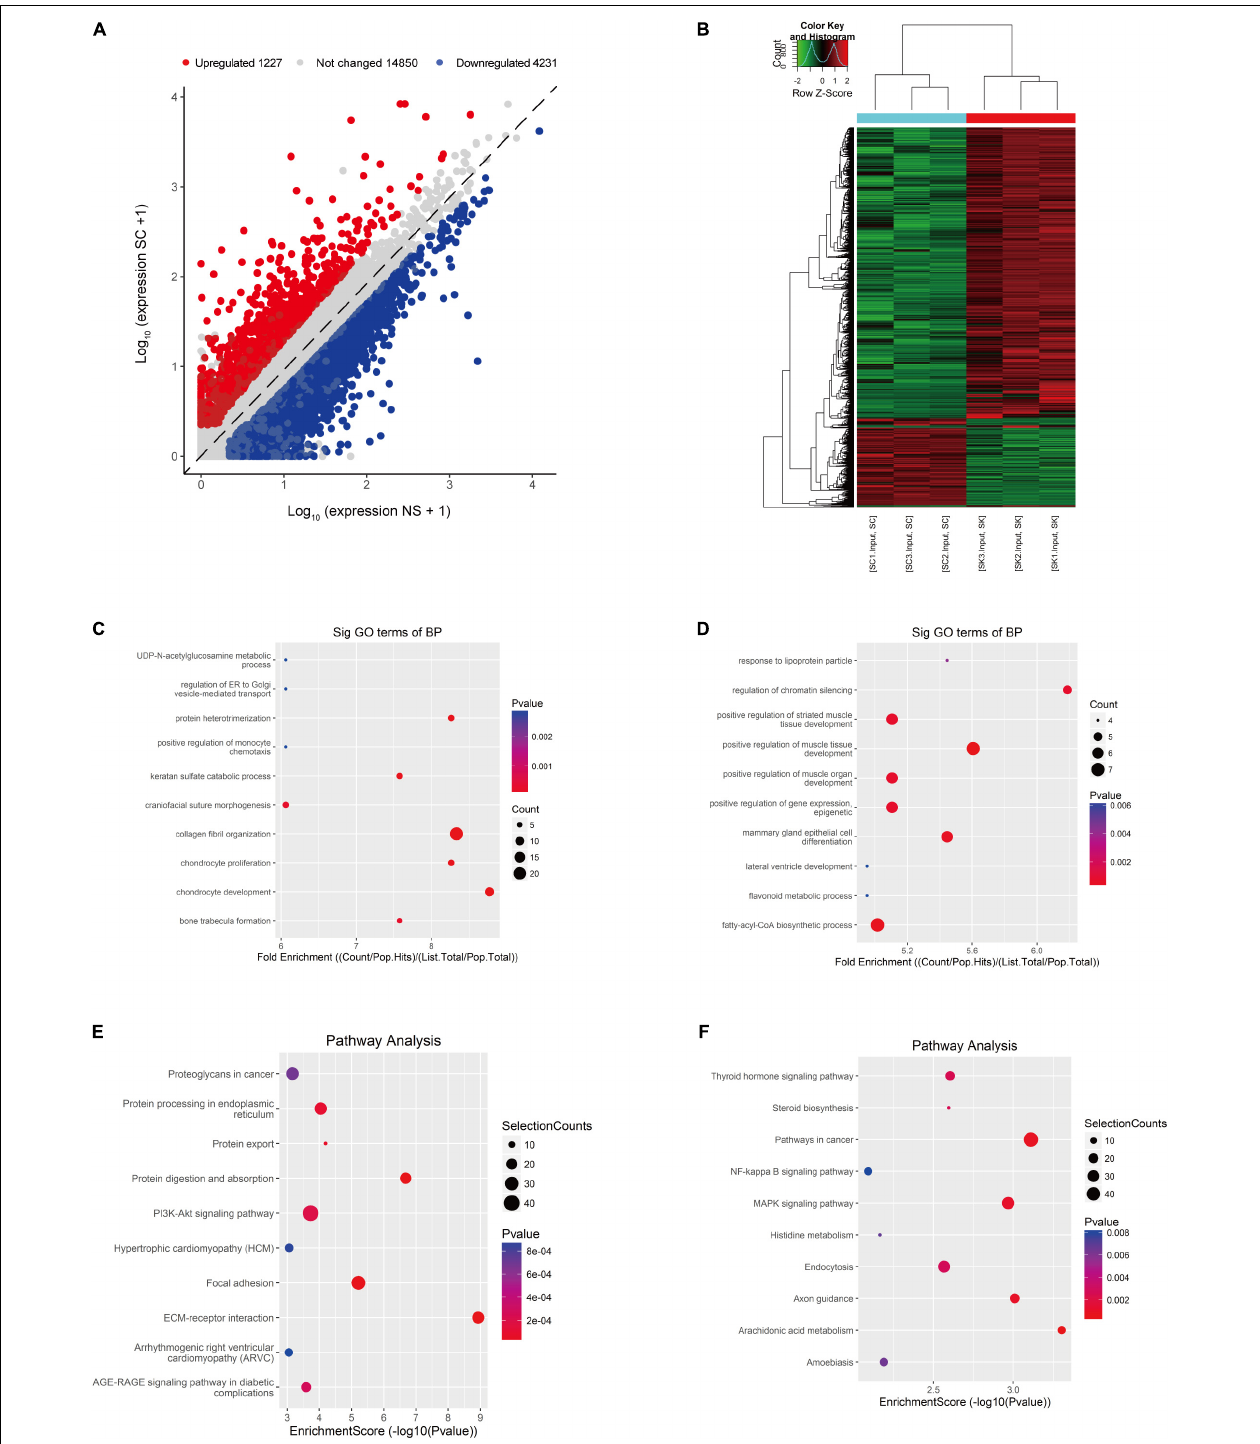
FIGURE 3 | Identification of differentially expressed genes (DEGs) in HS by RNA-seq. (A) Scatter plot of the RNA-seq data. (B) Heat map of RNA-seq data of HS and NS samples. Rows: mRNAs; columns: normal skin group and hypertrophic scar samples. Red, black, and green indicate the upregulation, unchanged expression, and downregulation of mRNAs, respectively. (C) Gene ontology (GO) analysis of the biological process involved in upregulated genes in HS samples conducted by top GO. (D) GO analysis of the biological process involved in downregulated genes in HS samples conducted by top GO. (E) Gene set enrichment pathway analysis of transcripts with increased mRNA modification in HS samples compared with NS samples by top GO. (F) Pathway analysis of transcripts with reduced mRNA modification in HS samples compared with NS samples. HS, hypertrophic scar group; NS, normal skin group.